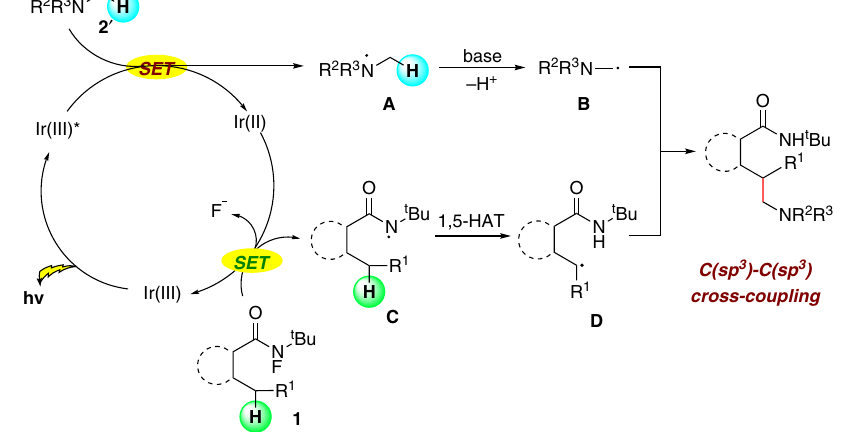
Fig. 3 Design plan for alkylation of tertiary amine α -C(sp 3 ) – H bonds. Hypothesis of the mechanism for photoinduced C(sp 3 ) – C(sp 3 ) coupling